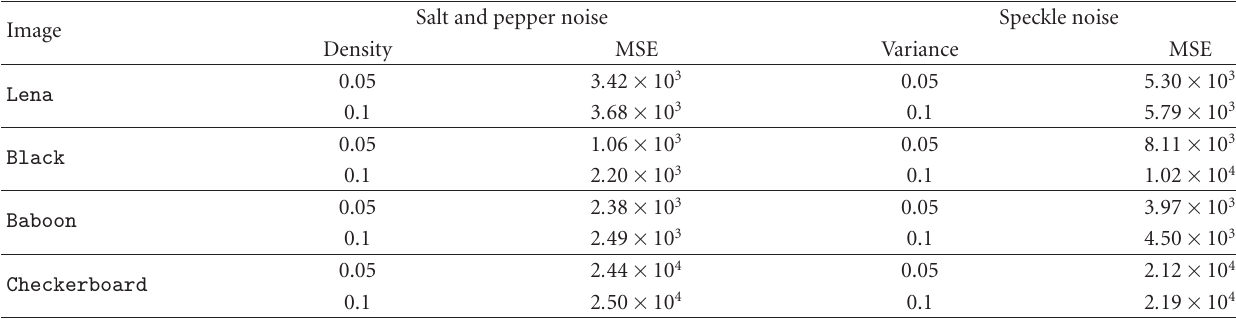
Table 6: MSE between original images and the decrypted versions under di ff erent noise attacks. Image